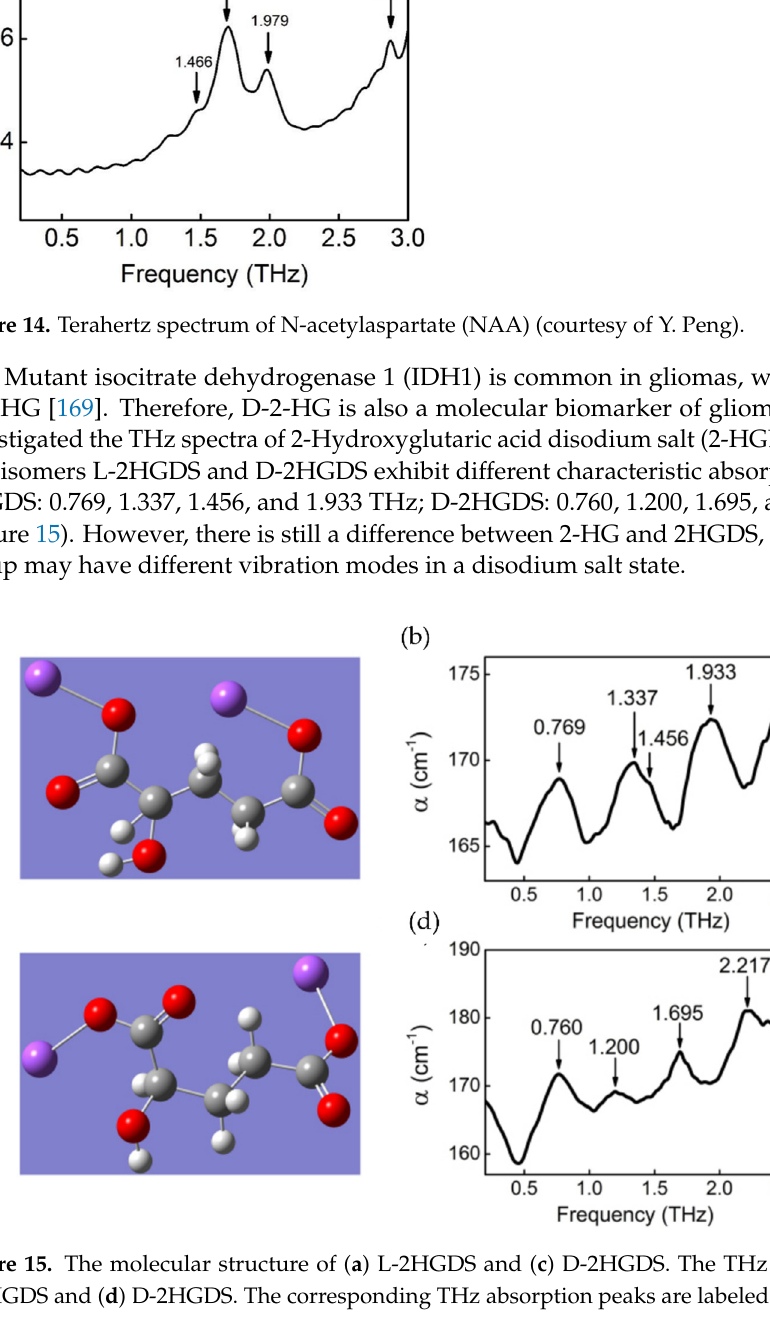
Figure 15. The molecular structure of ( a ) L-2HGDS and ( c ) D-2HGDS. The THz spectrum of ( b ) L-2HGDS and ( d ) D-2HGDS. The corresponding THz absorption peaks are labeled [169].